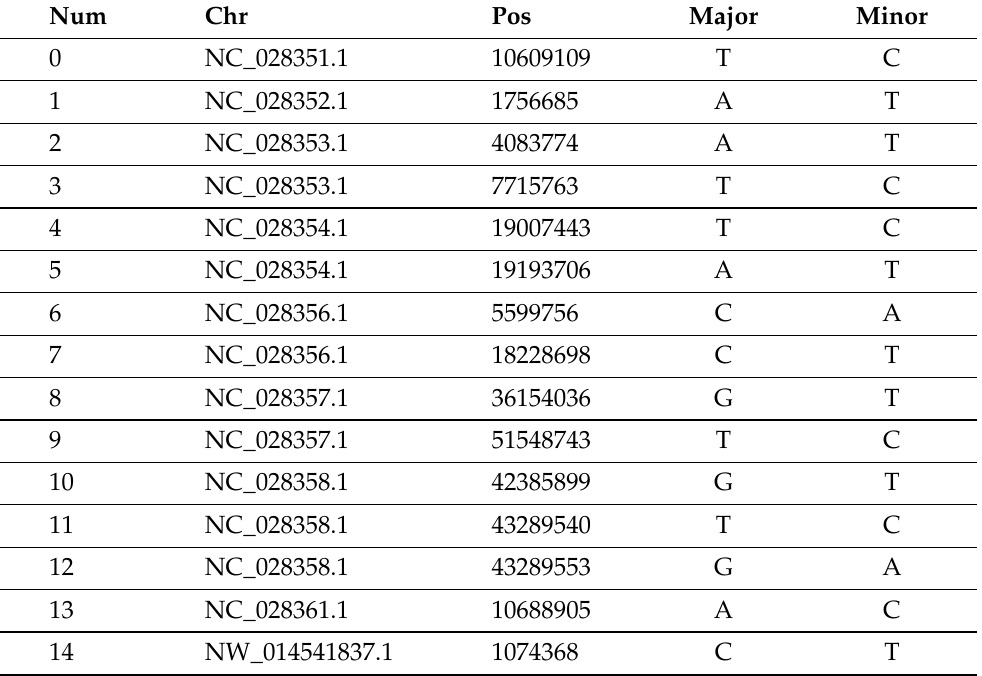
Table 2. Selected 15